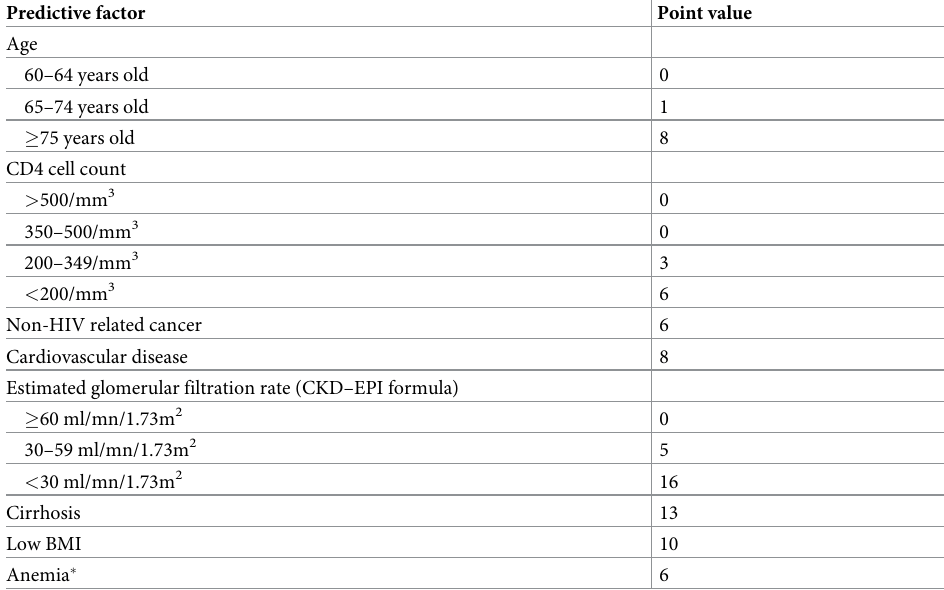
Table 3. Point value assigned to each predictor of 5-year overall mortality.